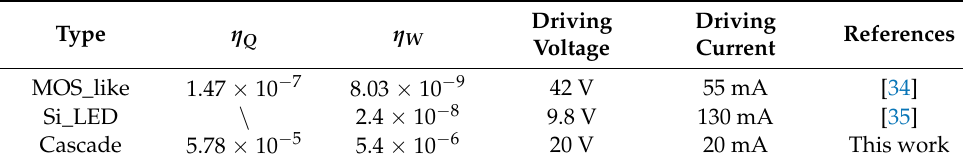
Table 1. Comparison of properties of several silicon-based light